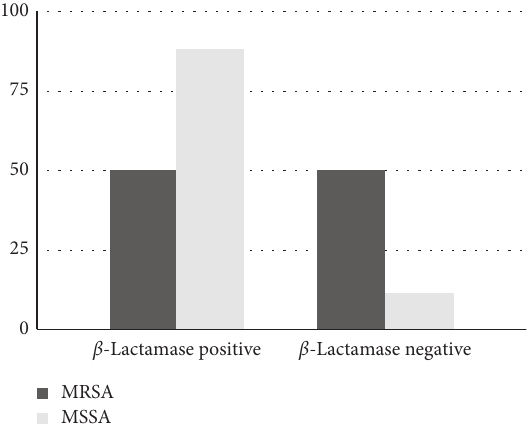
Figure 7: β -Lactamase production among MSSA and